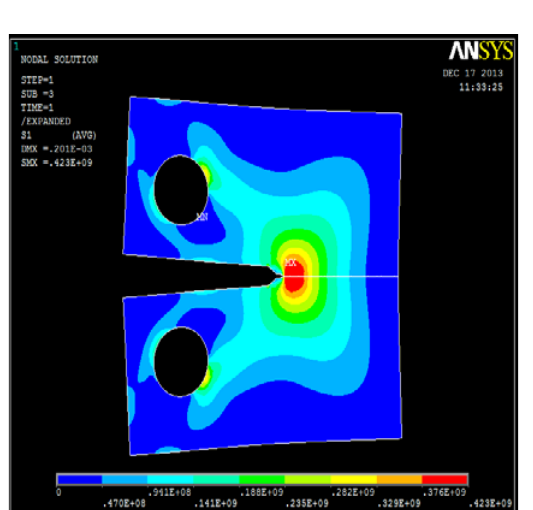
Figure 12: Principal stress distribution in CT specimen